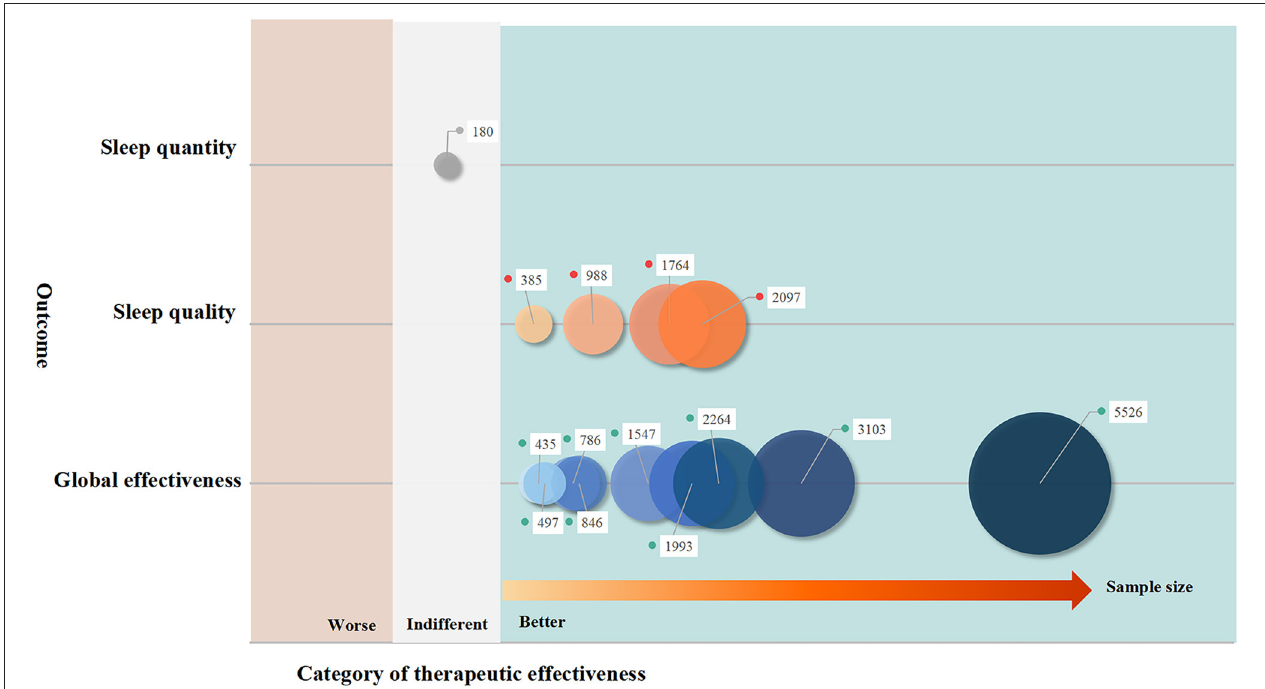
FIGURE 5 | The effectiveness of traditional Chinese medicine on post-stroke sleep disorders: evidence synthesis of systematic reviews. The size of bubbles is decided by the sample size included to the pairwise comparison in terms of certain outcome measurements. Better: the meta-analysis favoring traditional Chinese medicine; worse: the meta-analysis favoring comparators; indifference: there is no statistical difference between traditional Chinese medicine and comparators in the meta-analysis.